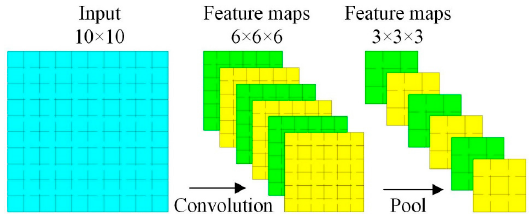
Figure 2. Single Convolutional Neural Network.